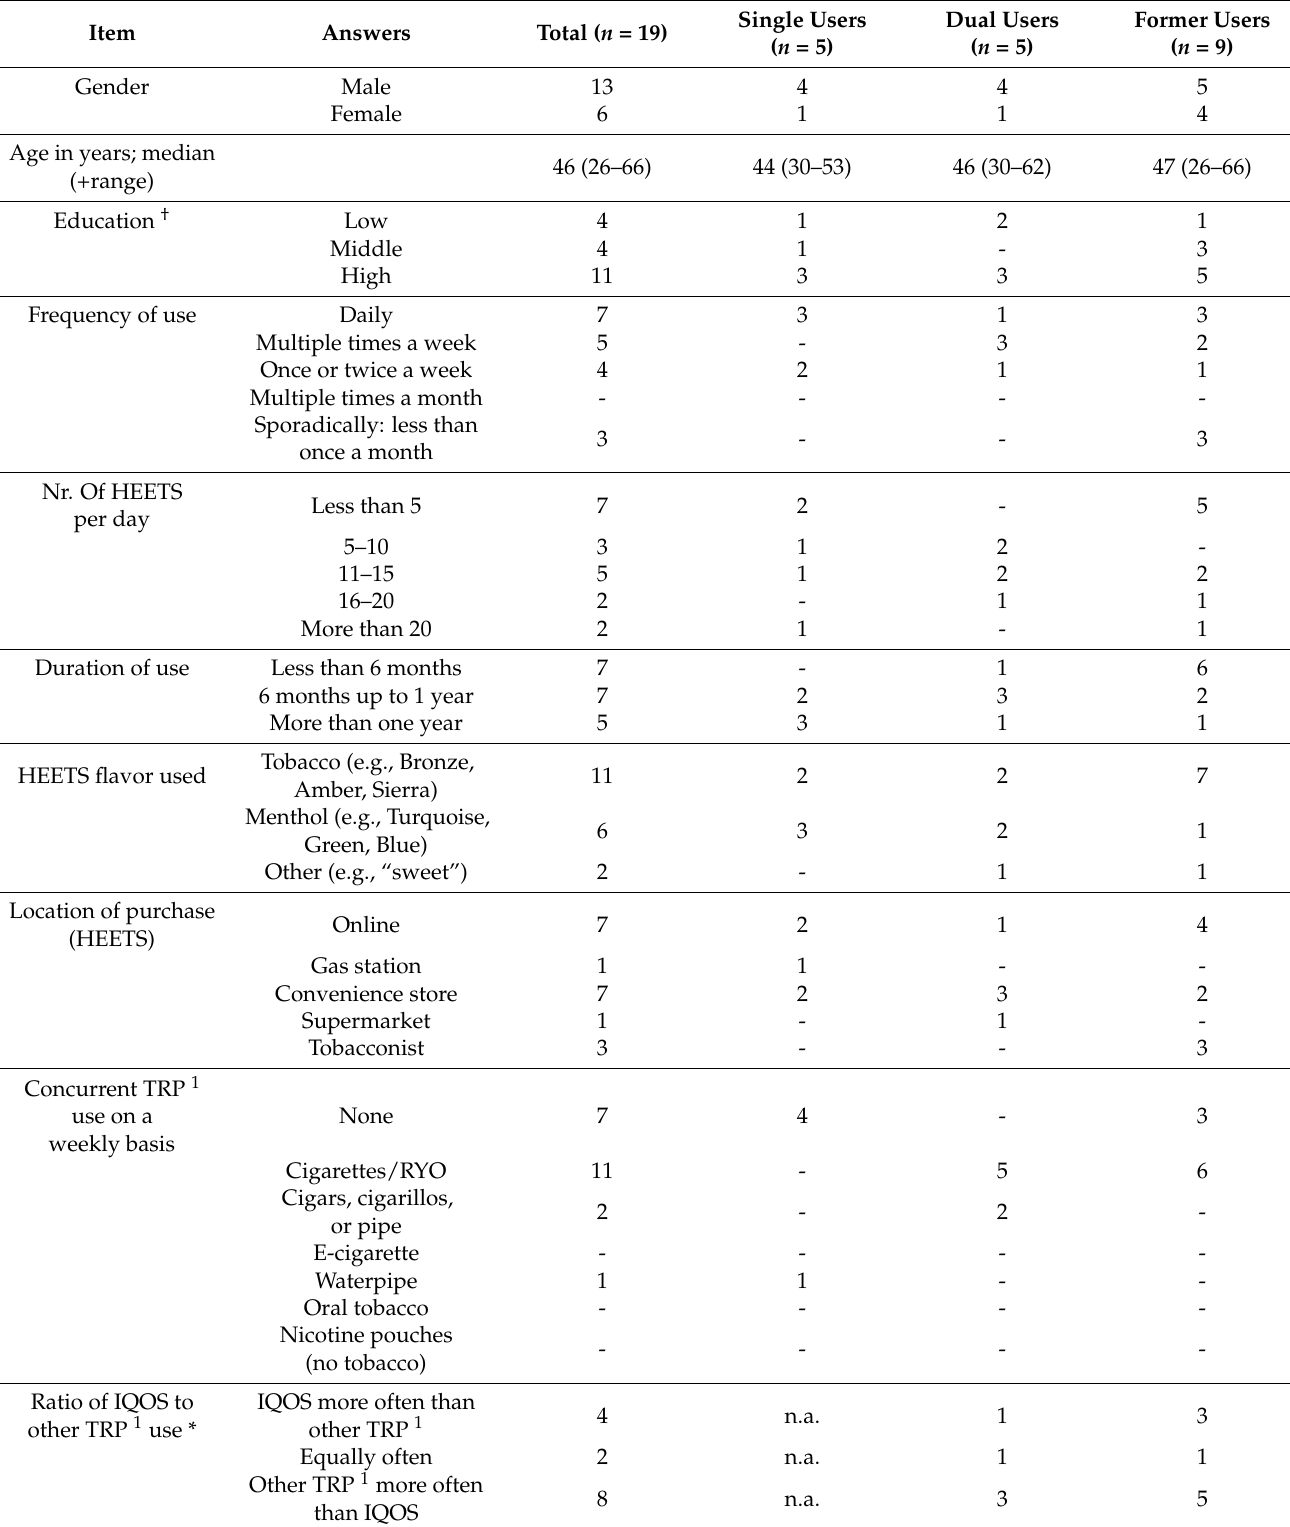
Table 1. Characteristics of the 19 participants per user